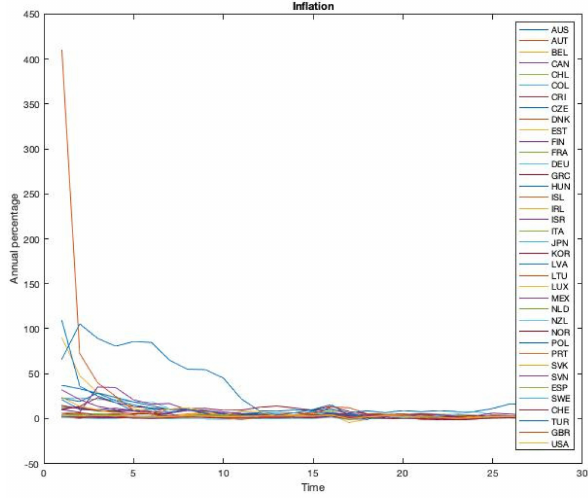
Figure 3. OECD members: inflation annual percentage.